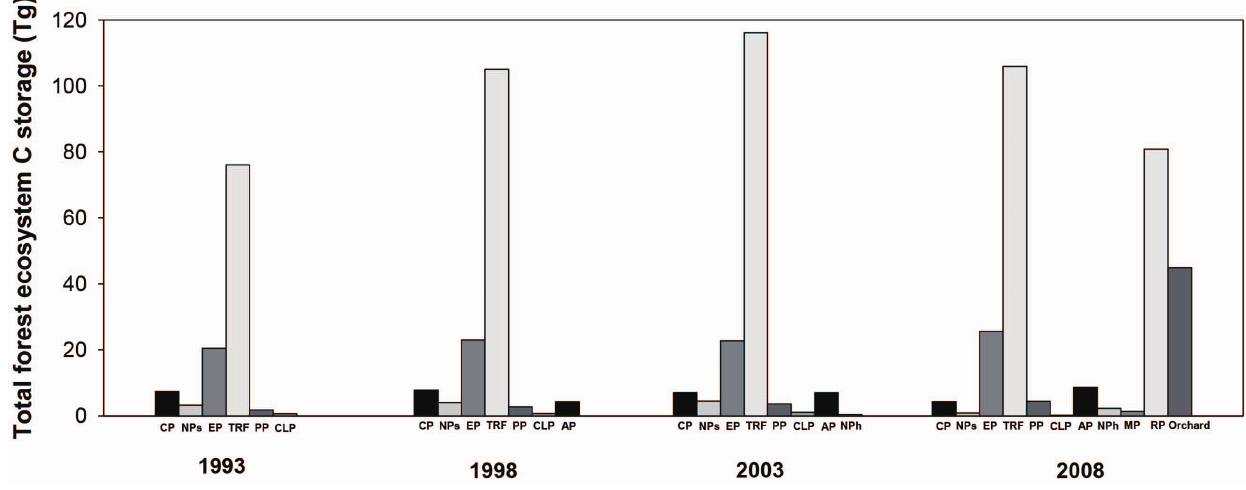
Figure 3. Total C storage of different forest ecosystems on Hainan Island during 1993–2008. CP: Casuarina plantation; NP (soft wood): Native broad-leaved species plantation (soft wood); EP: Eucalyptus plantation; TRF: Tropical rain forest (natural + secondary); PP: Pinus plantation; CLP: Cunninghamia lanceolata plantation; AP: Acacia plantation; NP (hard wood): Native broad-leaved species plantation (hard wood); MP: Mixed coniferous and broad-leaved tree species plantation; RP: Rubber plantation.